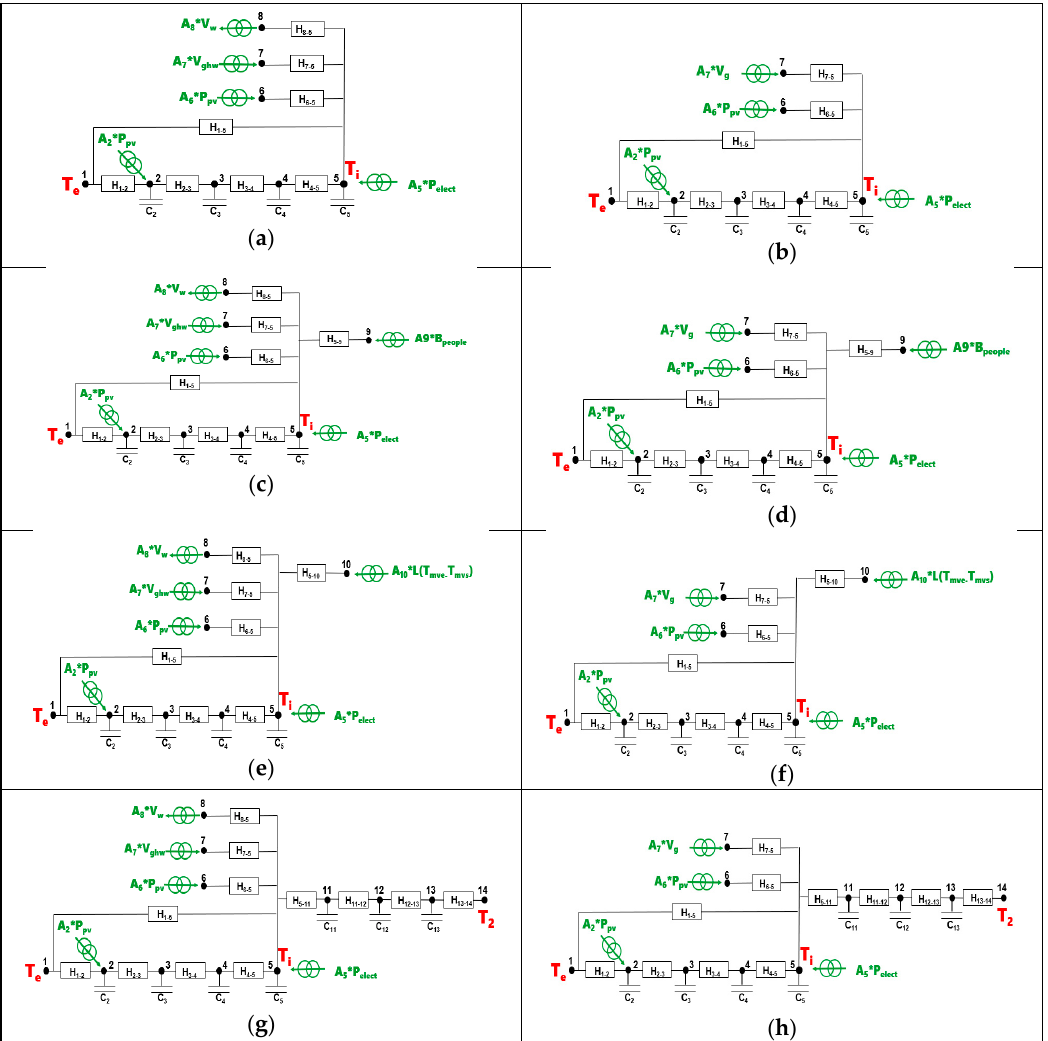
Figure 10. Models considered: ( a ) Model 1, ( b ) Model 2, ( c ) Model 11, ( d ) Model 21, ( e ) Model 12, ( f ) Model 22, ( g ) Model 13, ( h ) Model 23.